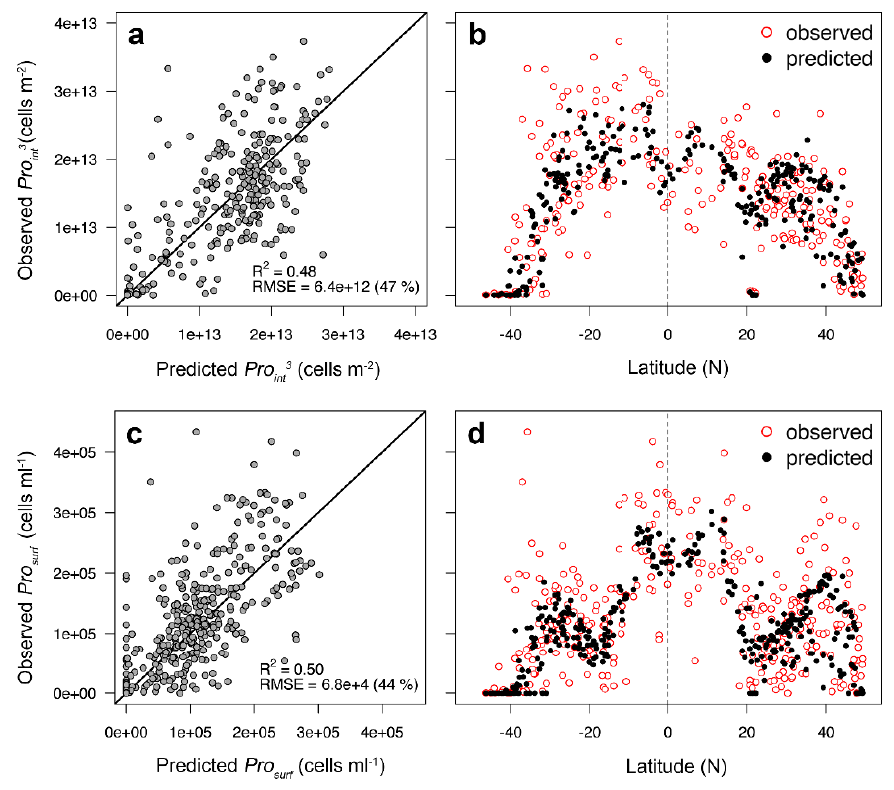
Figure 7. ( a ) Comparison between observed and predicted Prochlorococcus cell abundance integrated in the water column ( Pro int3 ) across the Atlantic Ocean (locations displayed in Figure 1) using the complete model (Equations (1) – (10) of the present work); ( b ) Observed and predicted Pro int3 across the Atlantic Ocean (AMTs 12 – 24); ( c ) Comparison between observed and predicted Prochlorococcus cell abundance at the sea surface ( Pro surf ) using Equations (3) – (5) of the present work; ( d ) Observed and predicted Pro surf across the Atlantic Ocean (AMTs 12 – 24).